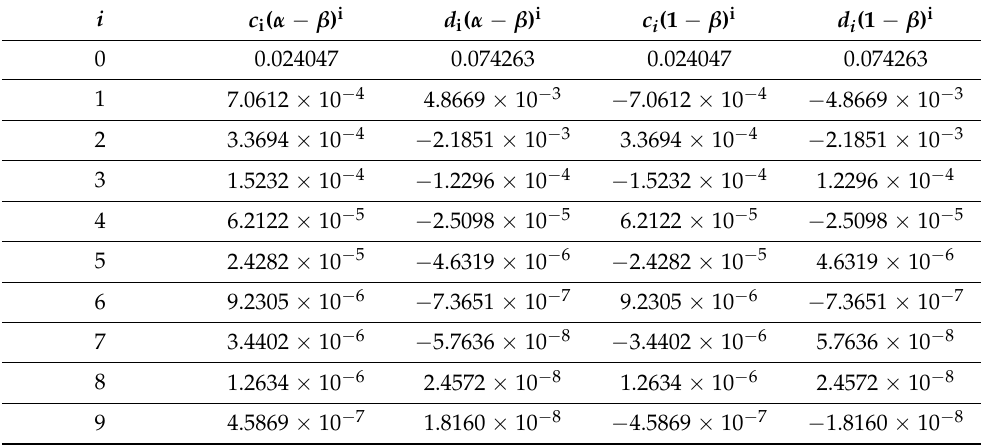
Table 2. The numerical calculation results of c i ( α − β ) i , d i ( α − β ) i , c i (1 − β ) i and d i (1 − β ) i , where q = 1.8 × 10 − 3